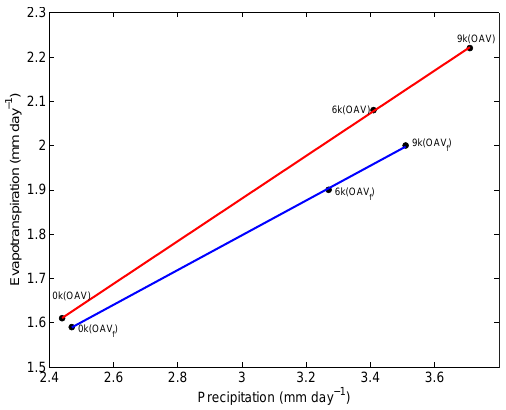
Figure 7. Mean summer evapotranspiration versus precipitation over the region 10–25 ◦ N, 20 ◦ W–30 ◦ E in the 0k, 6k, and 9k exper- iments with dynamic vegetation (OAV experiments; red) and with fixed vegetation (OAV f experiments;